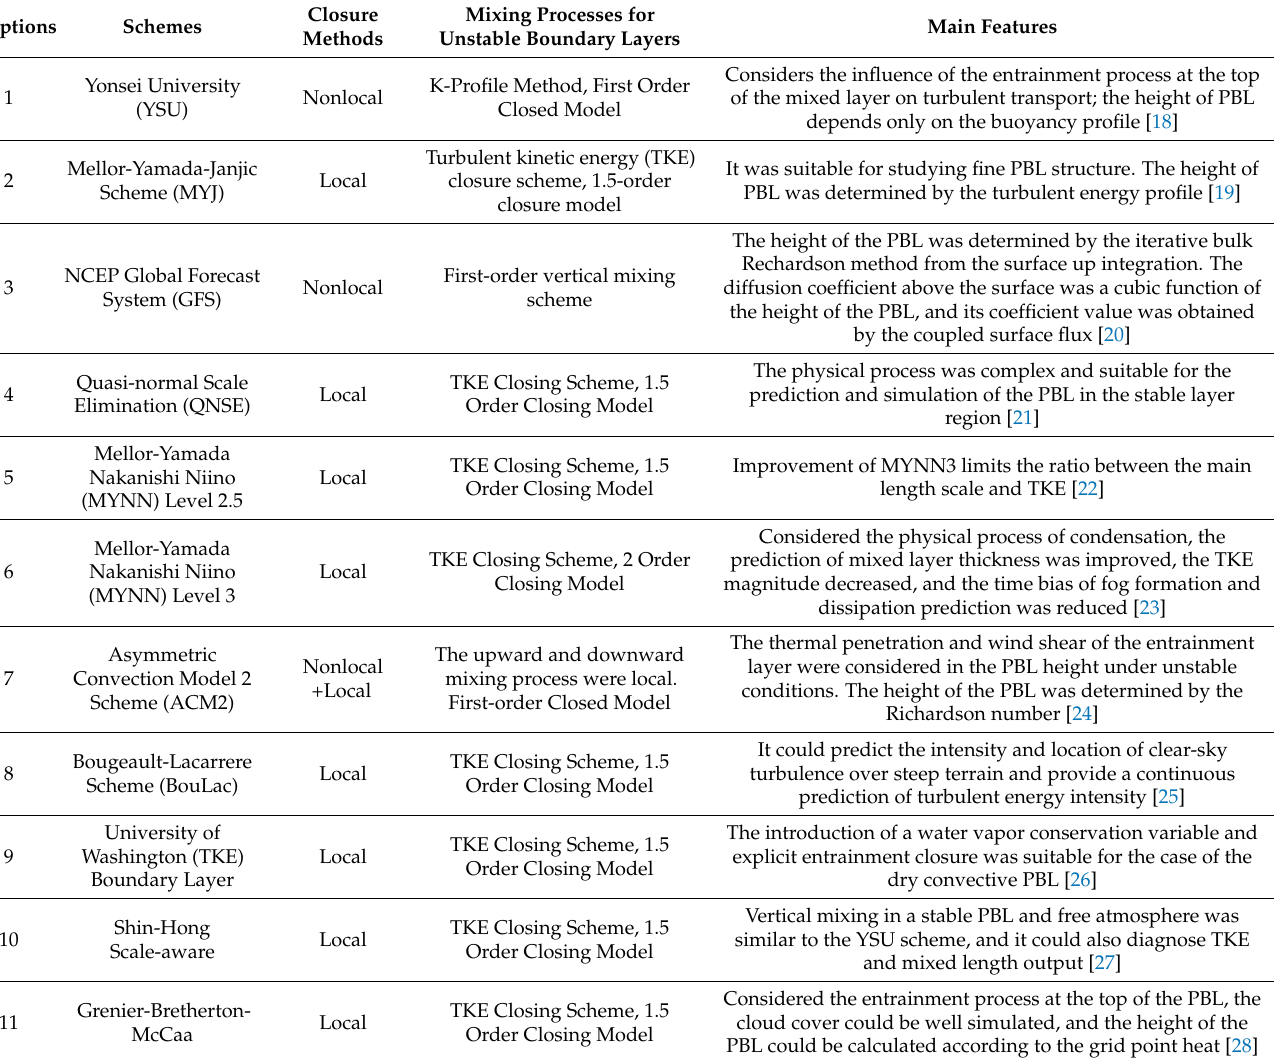
Table 1. Comparison of 11 planetary boundary layer